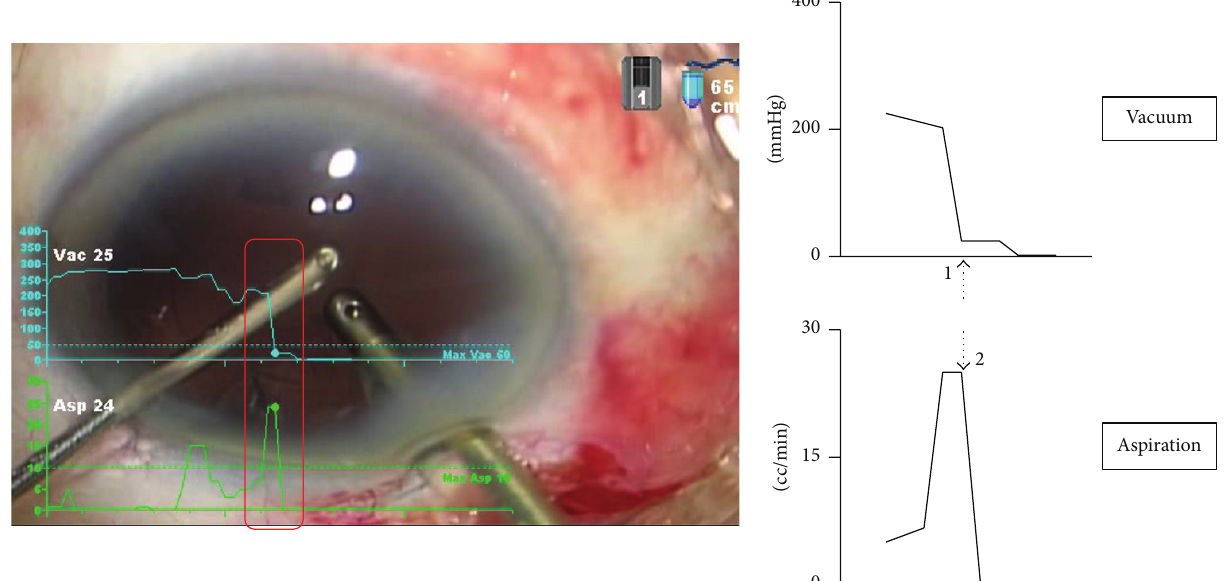
Figure 7: Accidental aspiration of the posterior capsule during aspiration of